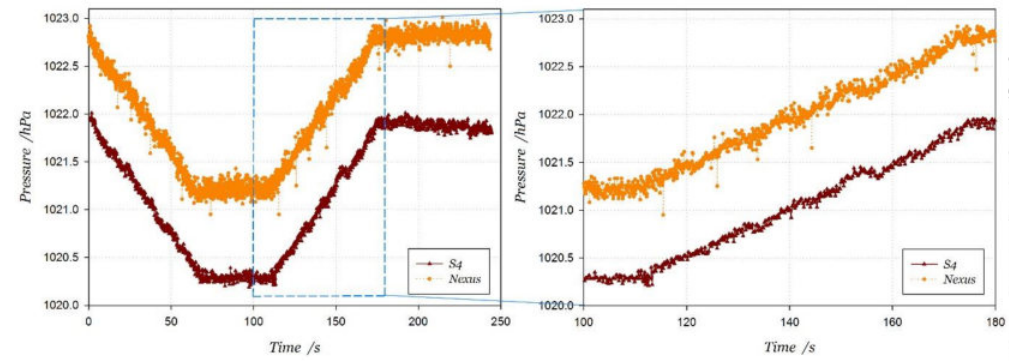
Figure 7. Air pressure data measured by two smartphones in Stair-up and